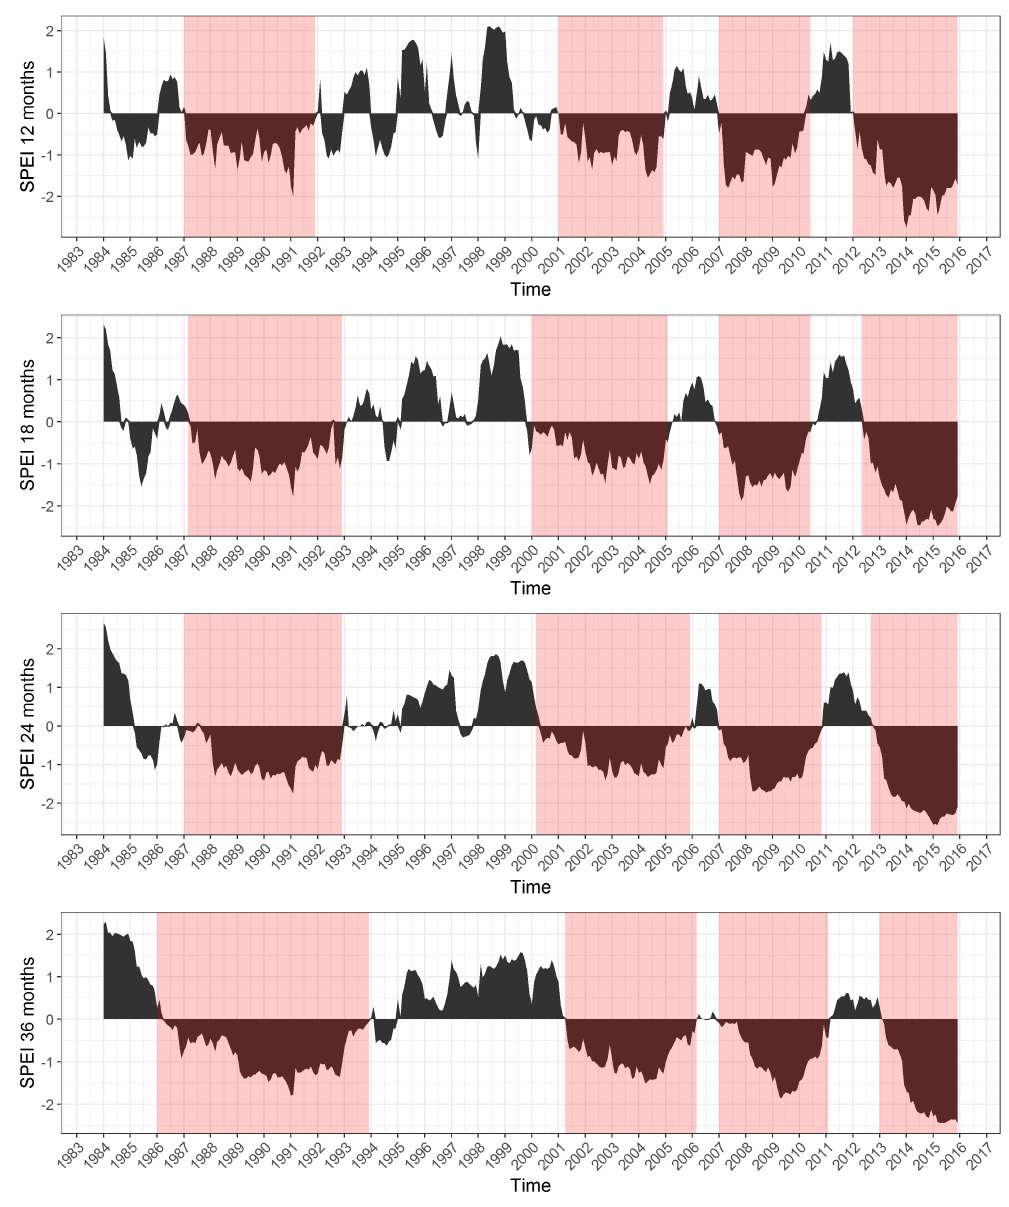
Figure 11. Standardized Precipitation Evapotranspiration Index on multiple time scales for San Joaquin Drainage climate